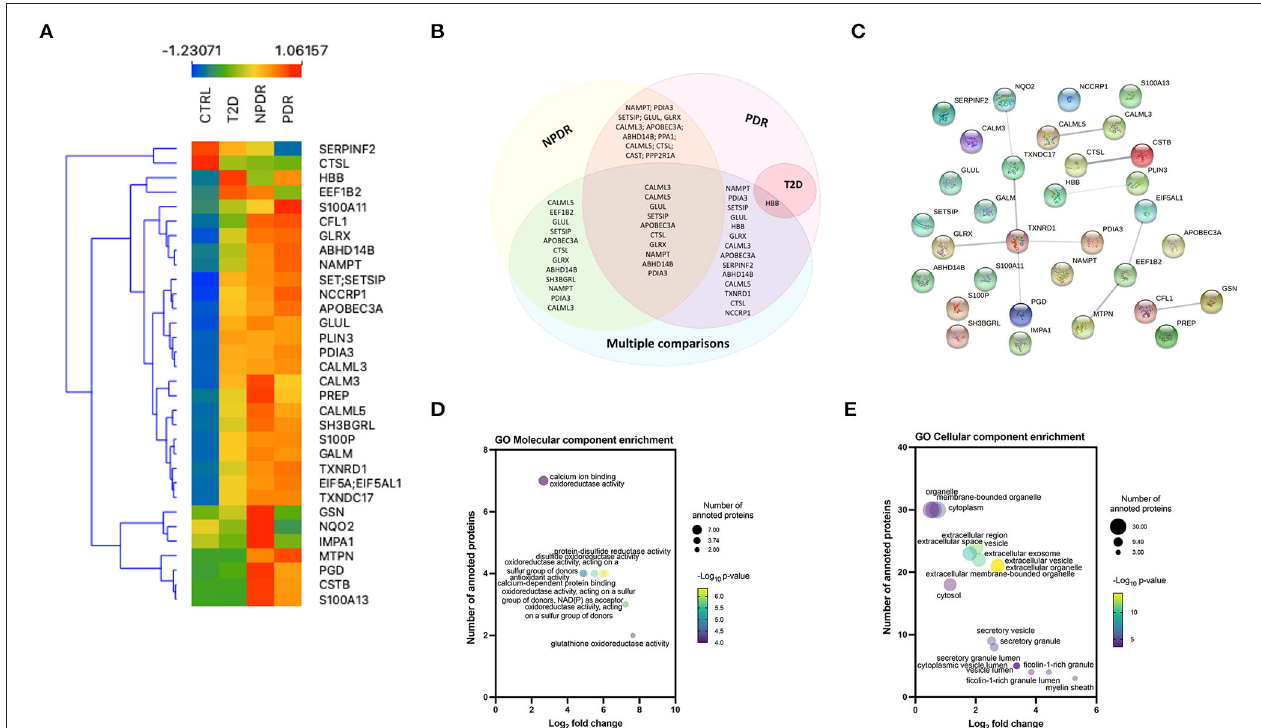
FIGURE 4 | Multiple comparison analysis between the diabetic subgroups and the control group. (A) Heatmap of the 32 significantly expressed proteins across replicates among diabetic subgroups and control group, showing a clear distinction between all the groups, and NPDR and PDR subgroups compared to control group. (B) Venn diagram displaying the overlapping statistically significant proteins between each diabetic subgroup vs. control group and, the comparison of the different groups with each other (multiple comparison). (C) STRING network interactome analysis of statistically significant proteins in multiple comparison. PPI enrichment p -value: 0.00357. Each node represents the 32 statistically significant proteins, the 11 edges represent the protein-protein associations (functionally or physically) and each edge strength represents the confidence of interaction. (D) Bubble plot displaying the significantly enriched GO Molecular function terms for significantly expressed proteins. The log 2 fold change in x-axis represents the ratio of proteins; the size of the bubble represents the number of proteins and color represents the statistical significancy. (E) Bubble plot displaying the significantly enriched GO Cellular component terms for the differentially expressed proteins in multiple comparison analysis. Extracellular vesicle and extracellular organelle represented by overlapping yellow bubbles, are the most significant cellular component. No statistically significant enrichment was obtained in biological process (data not